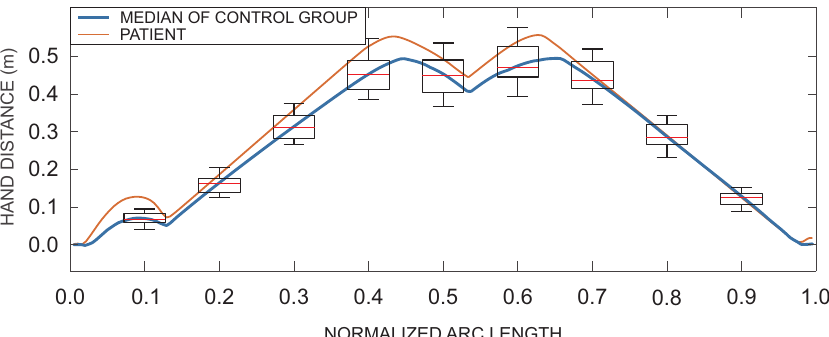
Figure 4. Hand distances for healthy subjects and a single patient for the task that requires grasping a block and transferring it onto a shelf. Median hand distance with box plots for control group (blue) and an example of patient’s hand distance